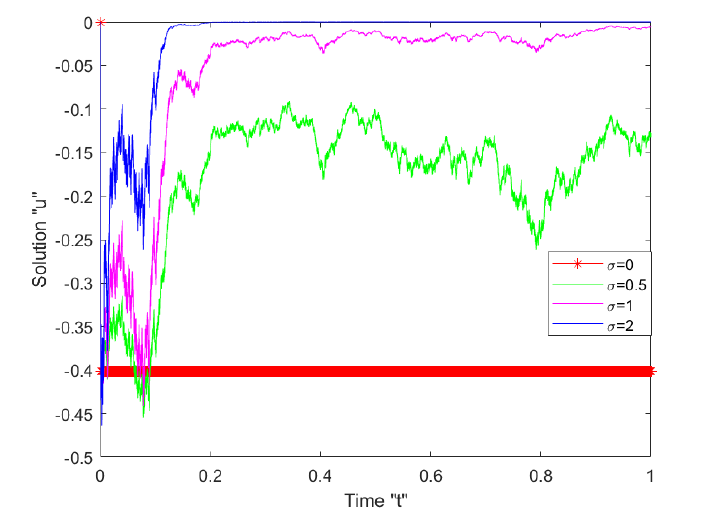
Figure 6. 2D graphs of the u in